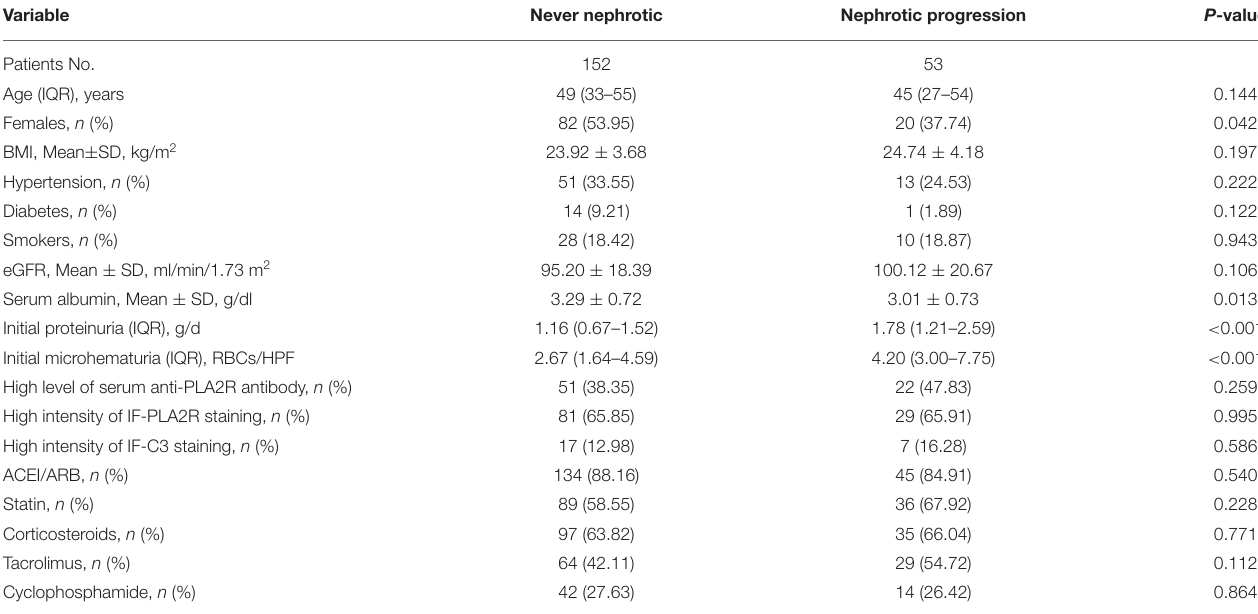
TABLE 4 | Clinical characteristics between never nephrotic and nephrotic proteinuria progression groups. Variable Never nephrotic Nephrotic progression P -value Patients No.